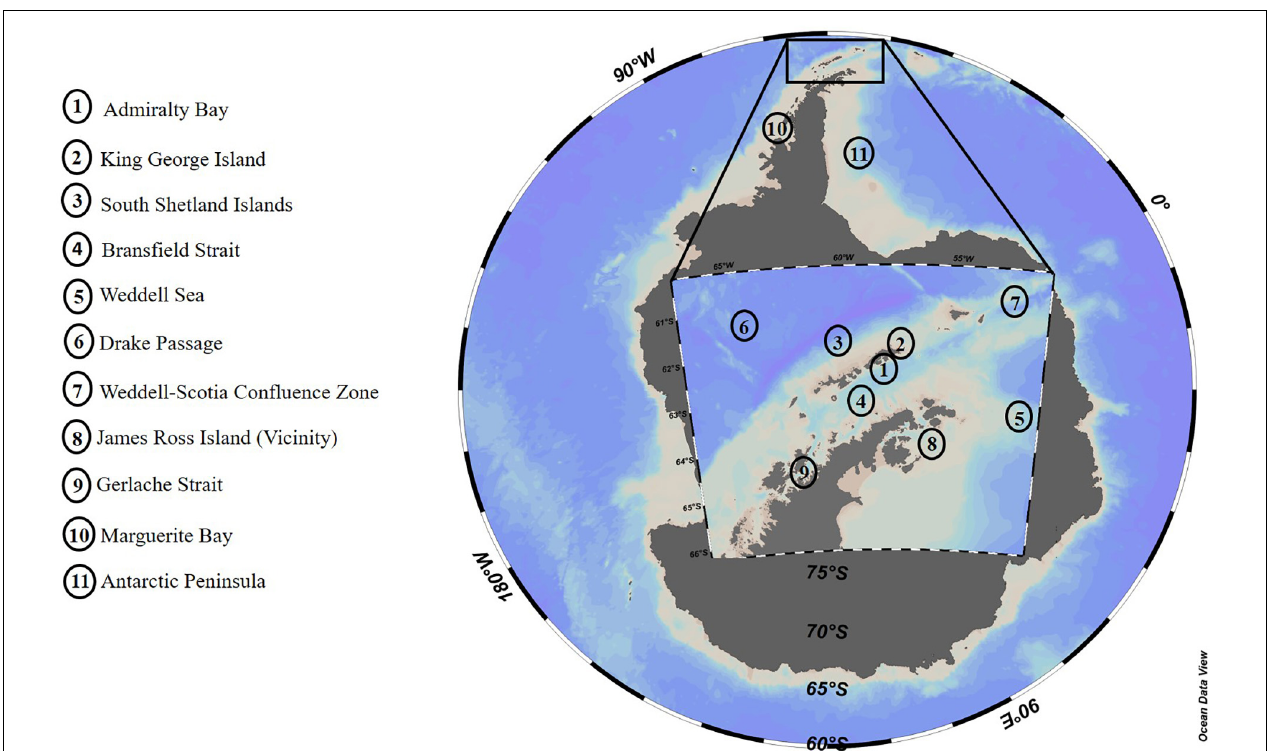
FIGURE 6 | WAP Subdivision for comparison with Admiralty Bay local environmental